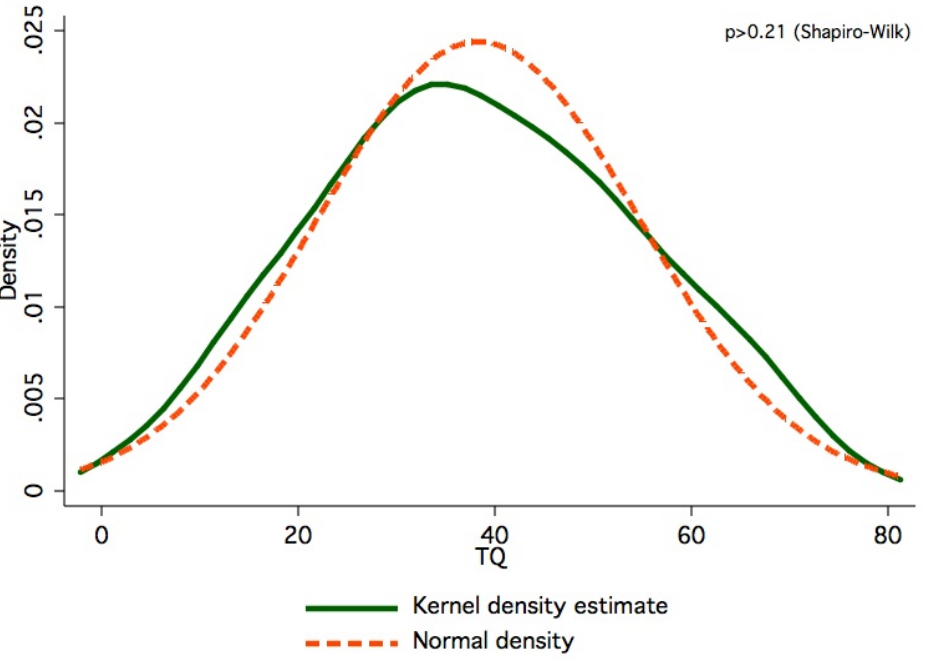
Figure 4. Distribution of TQ scores in 183 subjects with chronic